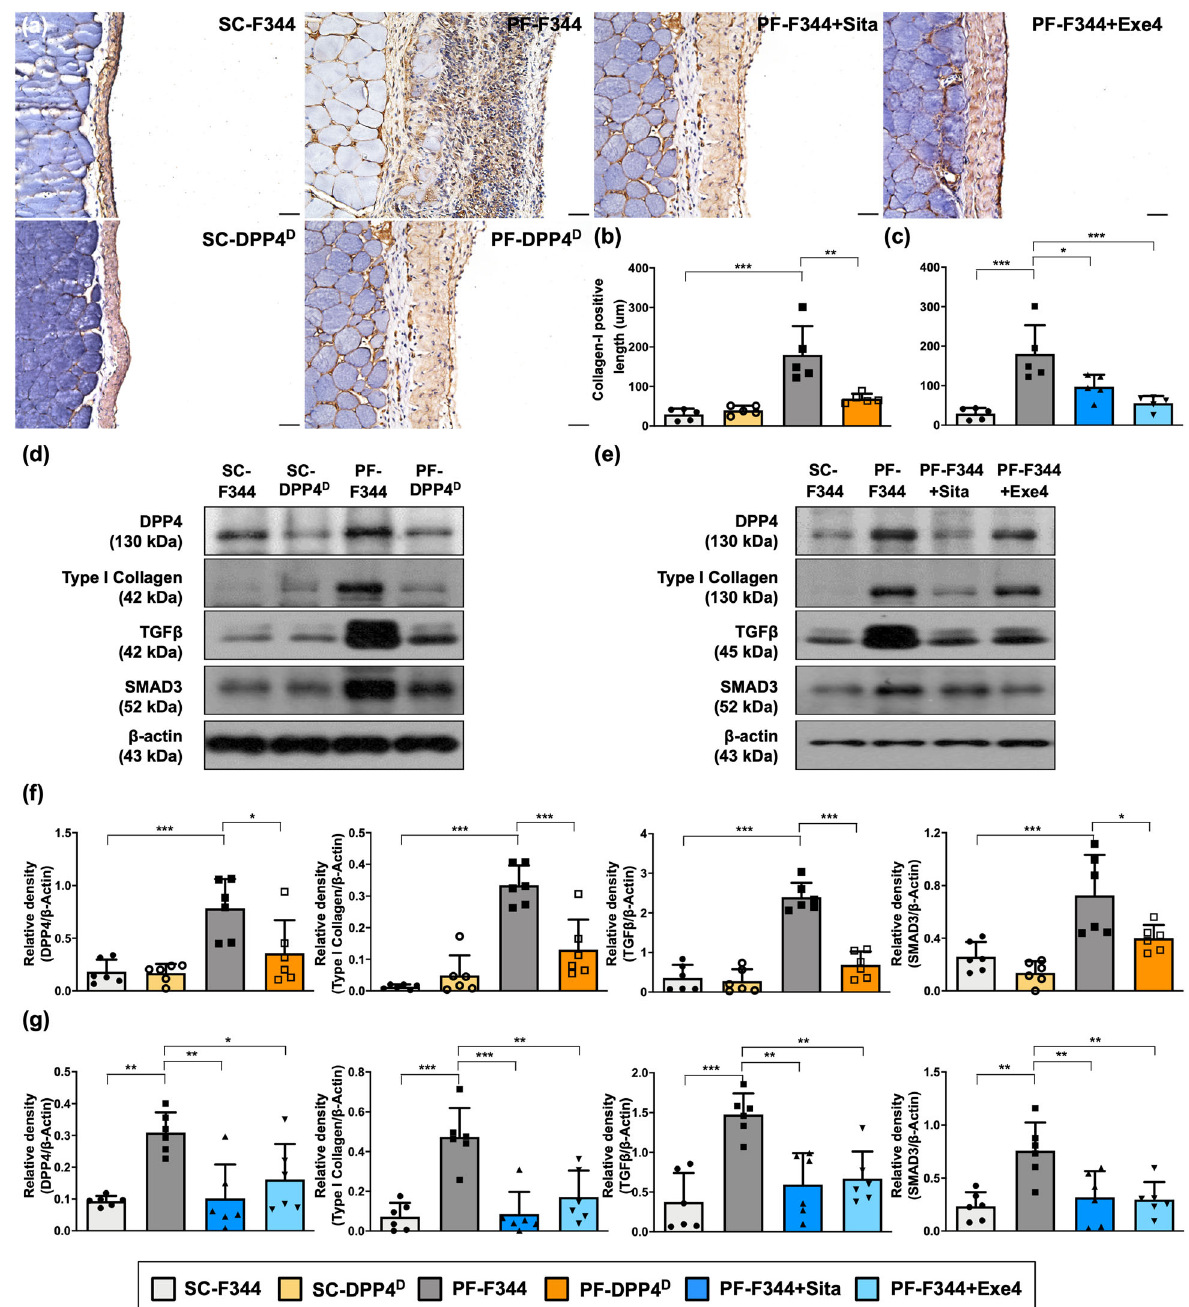
Fig. 5 DPP4 de fi ciency, sitagliptin, and exendin-4 reversed CG-inducing EMT process via SMAD3 pathway in rats. a Representative images (200×) of each group for identi fi cation of positively stained collagen-I (brown color) by immunohistology staining in peritoneal tissue after CG-inducing PF for day 21. Scale bars: 50 μ m. b , c Quantitative result of positively stained collagen-I length in the peritoneum of each group. d Western blotting was performed to detect the protein levels of DPP4, collagen-I, TGF- β , and SMAD3 in the peritoneal tissues of F344 wild type (F344) or DPP4 de fi cient (DPP4 D ) rats. e Western blotting was performed to detect the protein levels of DPP4, collagen-I, TGF- β , and SMAD3 in the peritoneal tissues for evaluating therapeutic protection of sitagliptin and exendin-4. f , g Quantitative results of Fig. 5d and Fig. 5e were shown, respectively. n = 6 for each group. Data represents mean ± SD; * indicates p -value <0.05; ** represents p -value <0.01; and *** is p -value